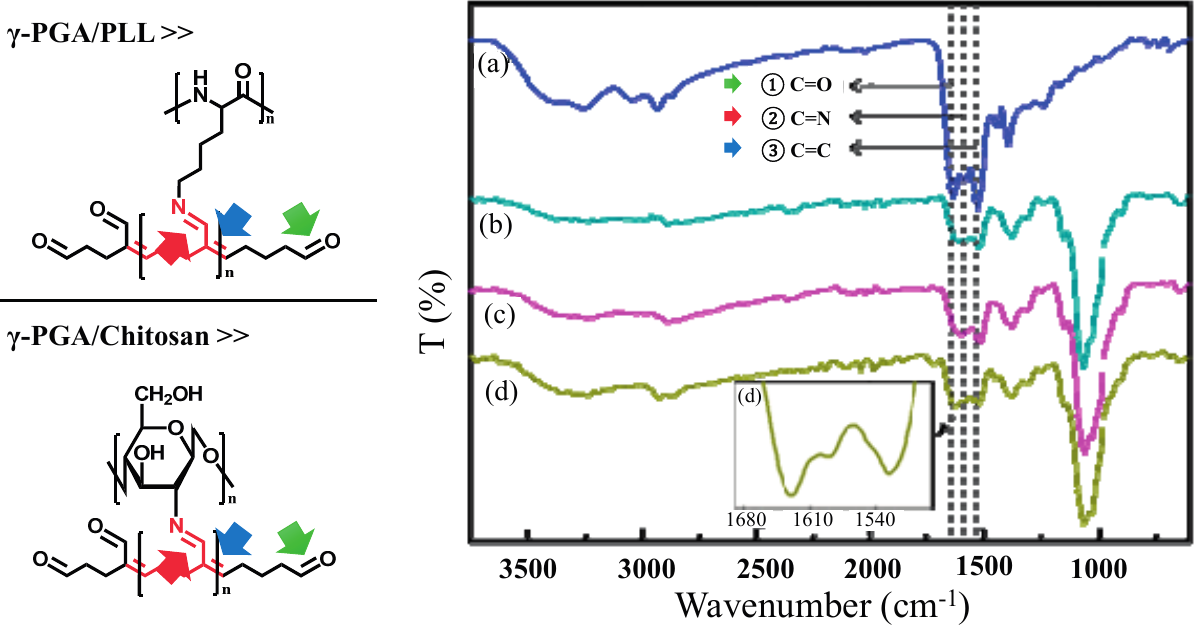
Figure 4. FT-IR spectra of (a) γ -PGA/PLL cross-linked with glutaraldehyde for 24 h, γ -PGA/Chitosan cross-linked with glutaraldehyde for (b) 30 min, (c) 24 h, and (d) 96 h. ( ① C=O (1629–1640 cm − 1 ), ② C=N (1589 cm − 1 ), ③ C=C (1514–1530 cm − 1